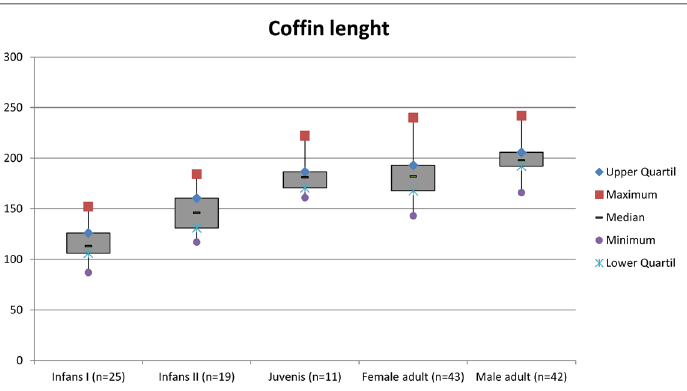
Figure 4: Box plots of coffin lengths and their variation within an age group / gender group (graphic arts: Karin